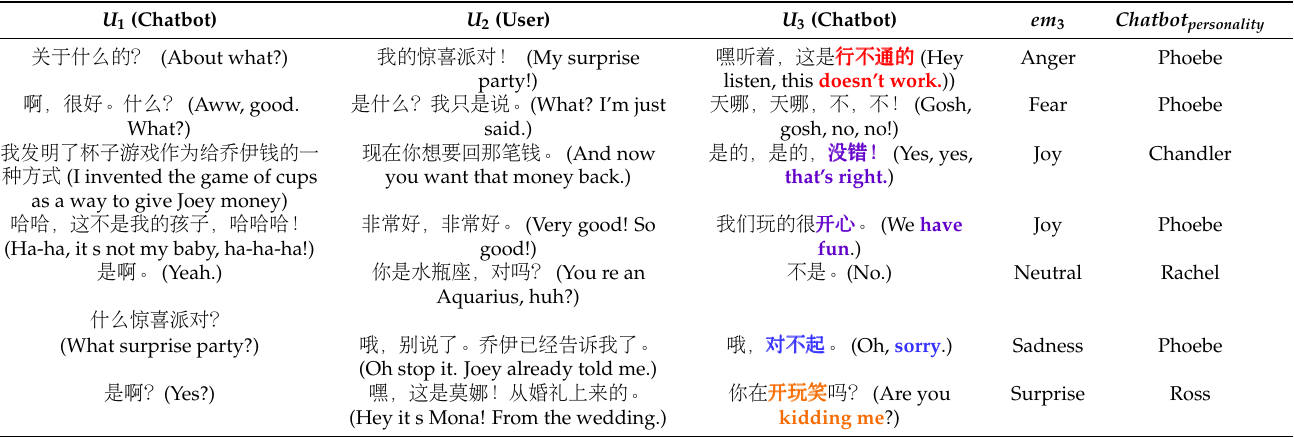
Table 3. Emotional responses generated by GERP. The emotion words, which include words and punctuation marks, are